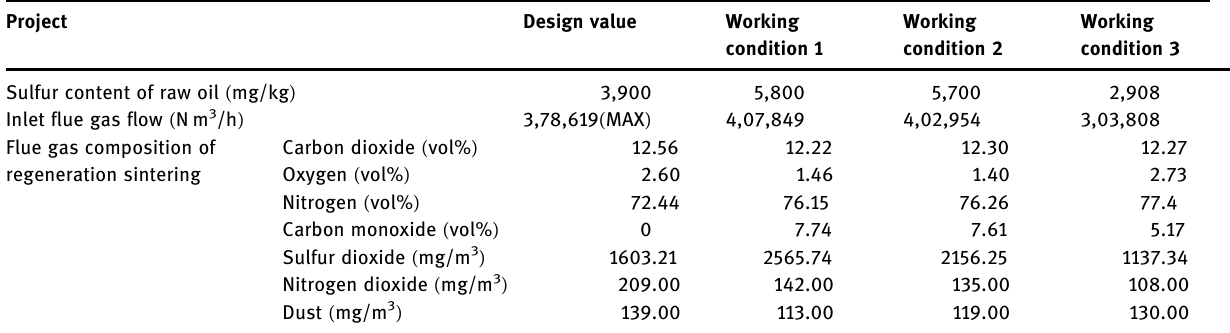
Table 1: Properties of regeneration sintering fl ue gas